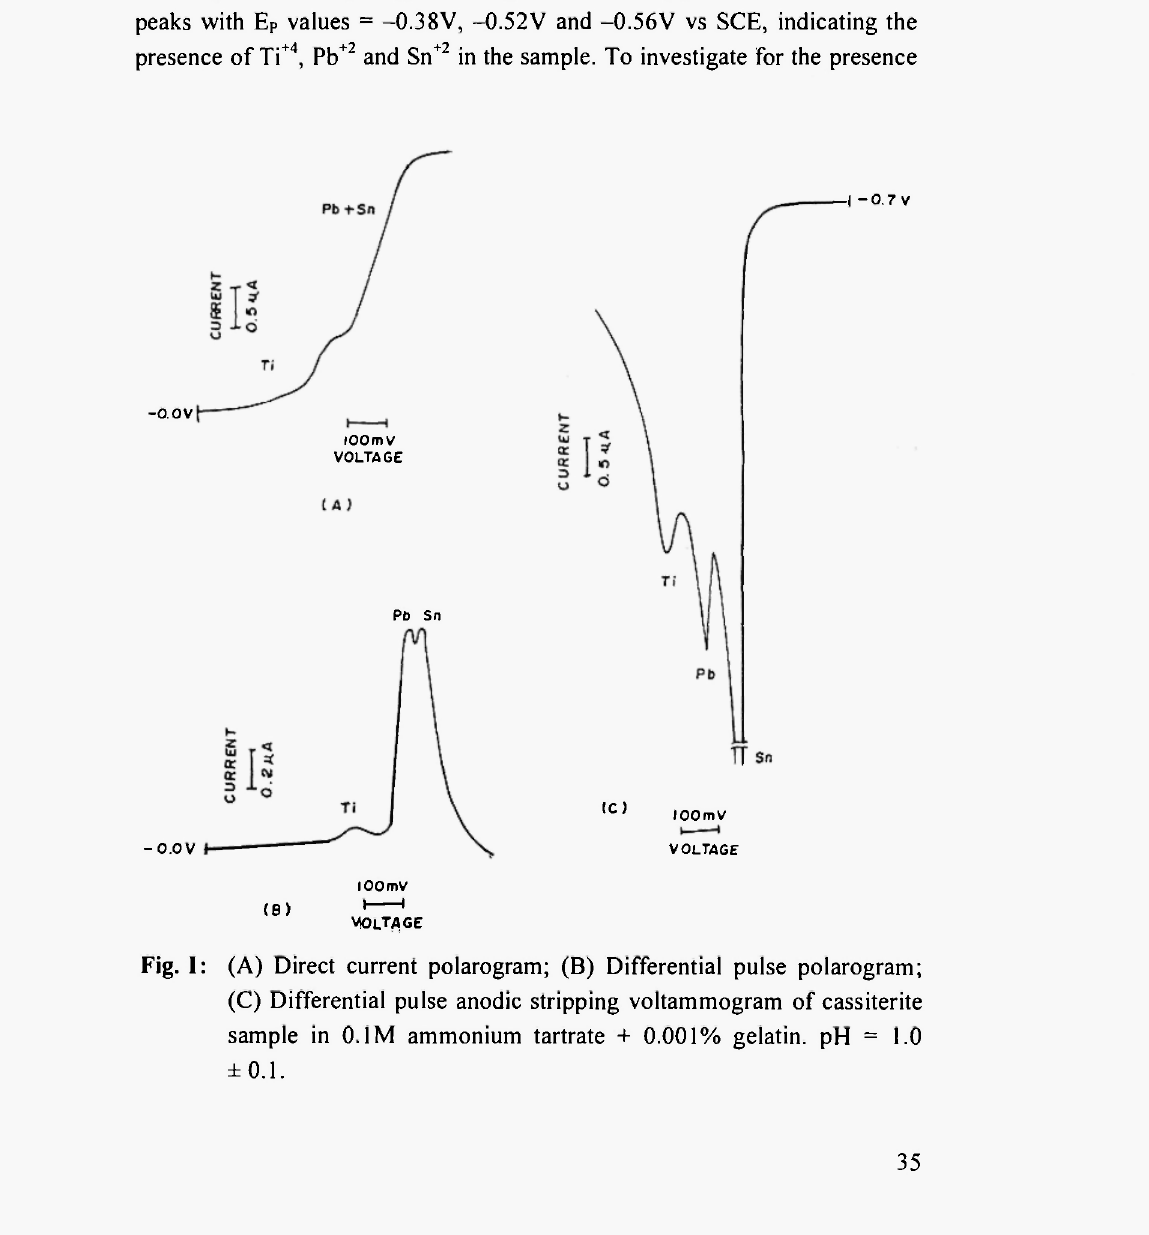
Fig. I: (A) Direct current polarogram; (B) Differential pulse polarogram; (C) Differential pulse anodic stripping voltammogram of cassiterite sample in 0.1 Μ ammonium tartrate + 0.001% gelatin. pH = 1.0